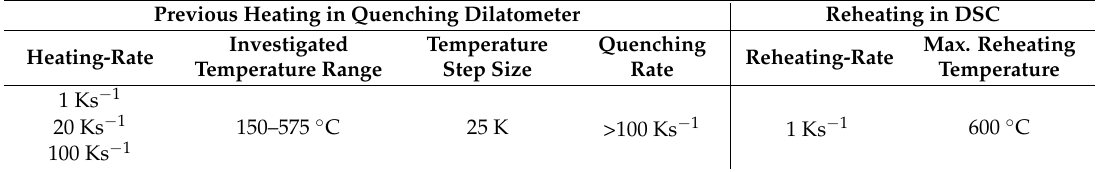
Table 1. Heat treatment parameters for indirect